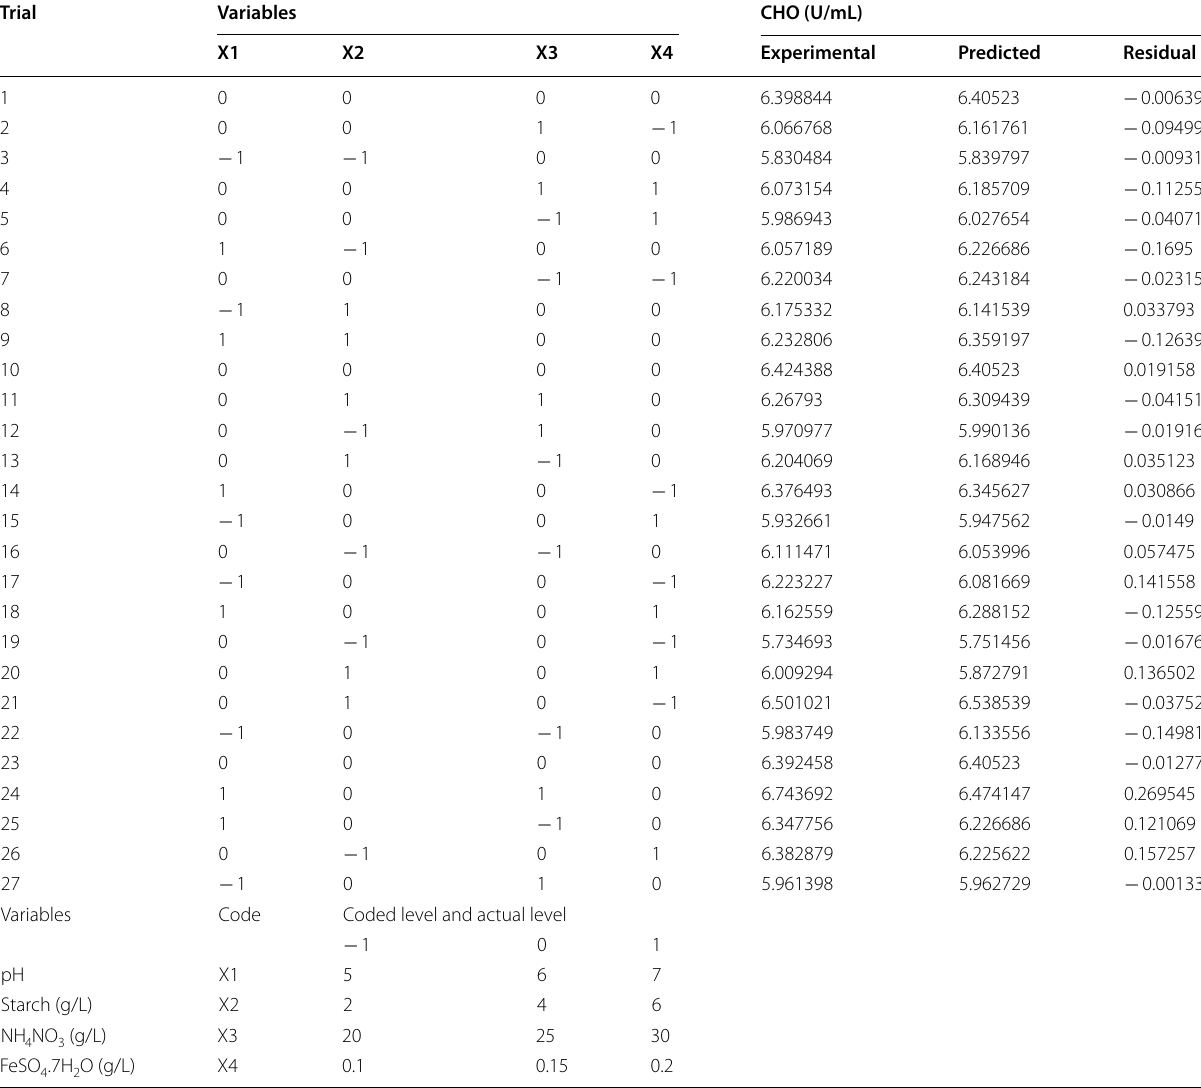
Table 3 BB designed matrix for the selected 4 variables influencing the CHO production by Streptomyces sp. strain AN Trial Variables CHO (U/mL) X4 Experimental